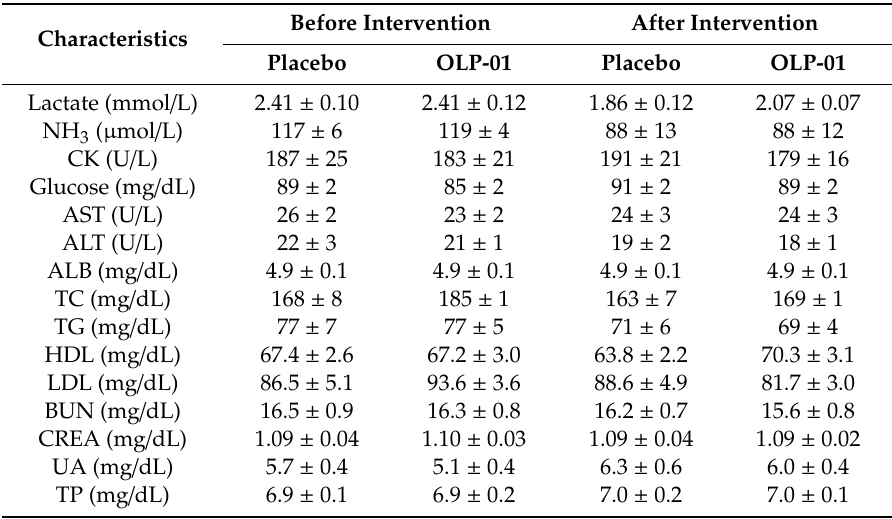
Table 3. Safety Assessment of Blood Biochemical of Subjects.